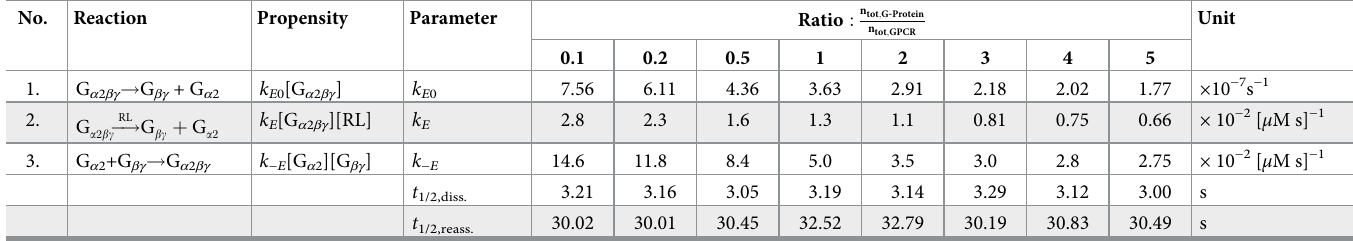
Table 2. Parameters for G-protein dynamics. Here, we varied the ratio of total number of G-protein (G α 2 βγ +G βγ ) to the total number of receptors; for each case, the reac- tion rate constants of G-protein dynamics were estimated to match the half times of dissociation ( t 1/2,diss. ) and reassociation ( t 1/2,reass. ) from [17]. In reaction no. 2, RL is the total occupied receptors (H:C + L:C + S:C + P H:C + P L:C).